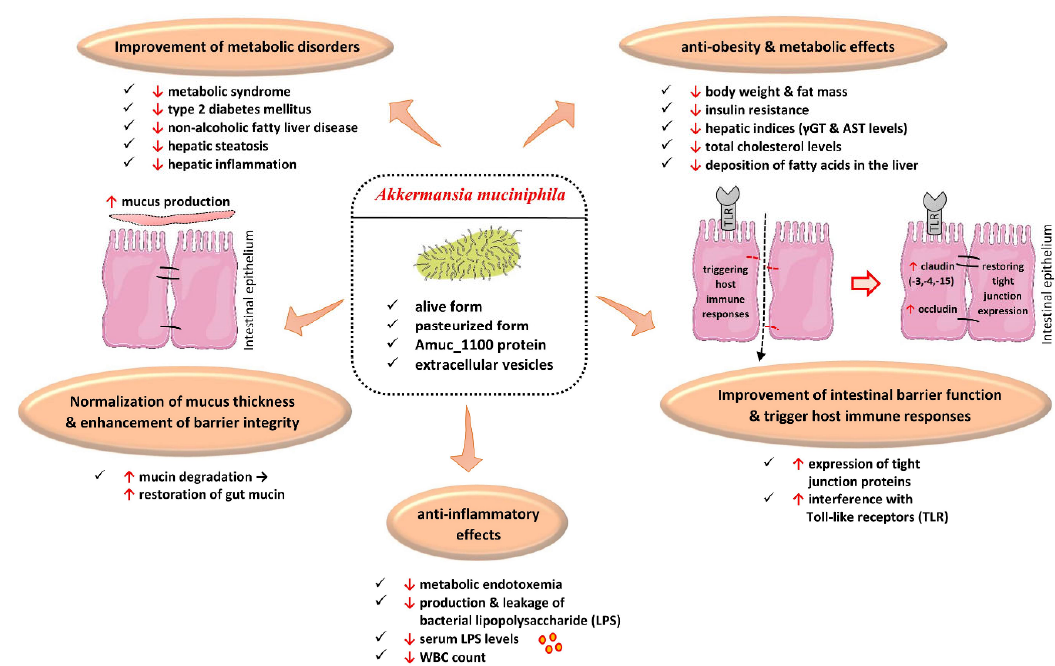
Figure 1. Effects of Akkermansia muciniphila and its derived products in obesity and its related disorders. ↑ , augmentation; ↓ , reduction; AST, aspartate-aminotransferase; γ GT, Gamma-Glutamyl- Transferase; WBC, white blood cell. (All images originate from the free medical site http://smart. servier.com/ by Servier licensed under a Creative Commons Attribution 3.0 Unported License; accessed on 2 February 2023).